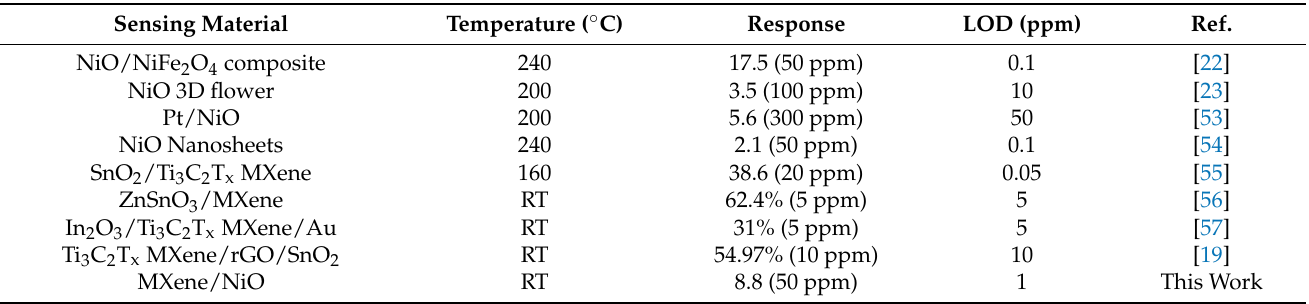
Table 1. Comparison of the performance of the sensors proposed in this work with previously reported sensors for HCHO